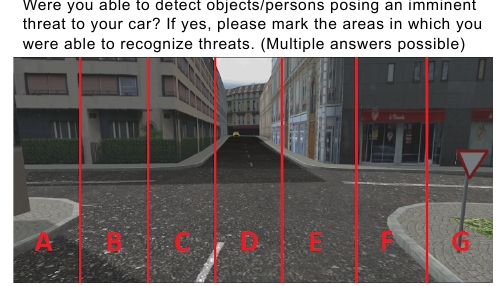
Figure 5. Example question of one of the four SA test questionnaires. Participants had to answer during a SAGAT-like freeze probe.